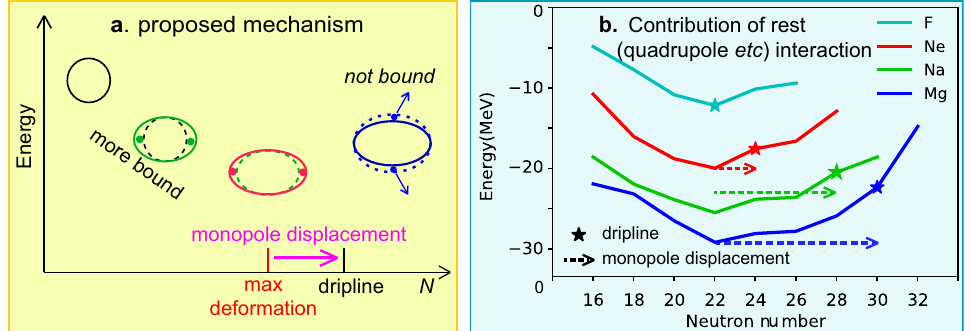
Figure 18. ( a ) Presently proposed mechanism based on shape evolution and the resulting change in the ground-state energy. ( b ) The rest-term contribution to the ground-state energies for F, Ne, Na, and Mg isotopes. Dashed arrows indicate the monopole displacement. See text for more details. Modified from Figures 2 and 6 of